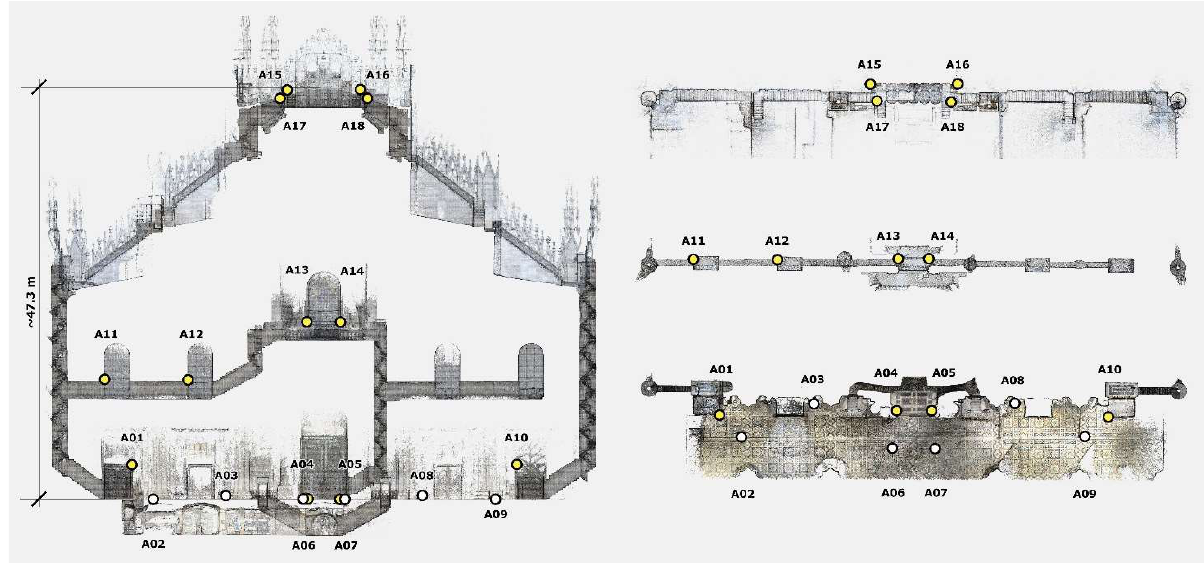
Figure 6. Point cloud result of Path A. Elevation view (left) and top view at three levels (right). According to Table 2, points in white are used as GCPs in the “max drift check”.